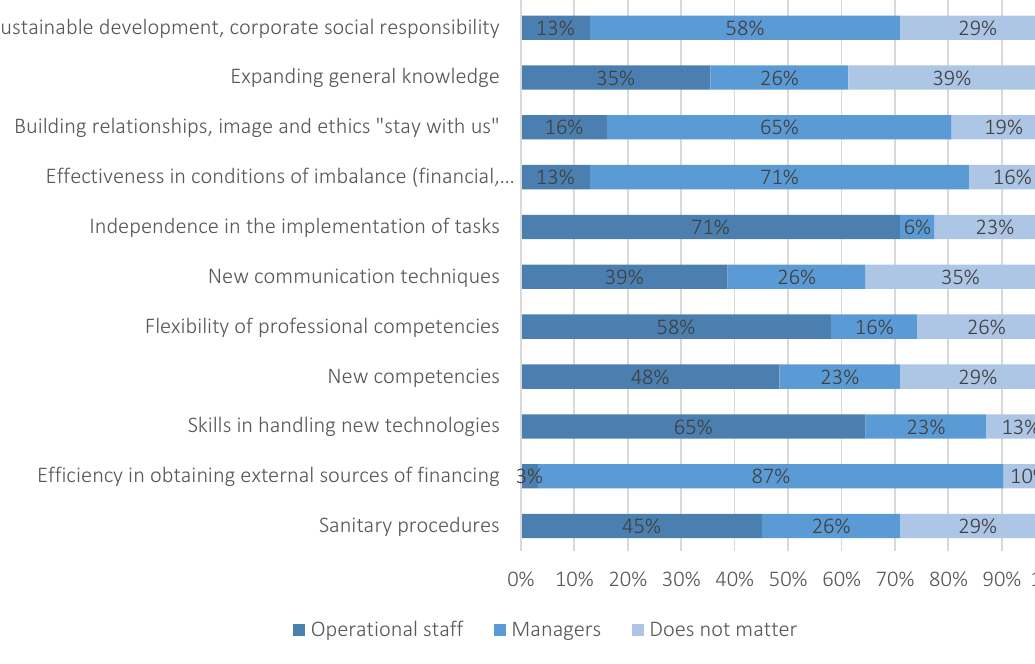
Figure 4. Areas of staff development in the MICE sector in the near future